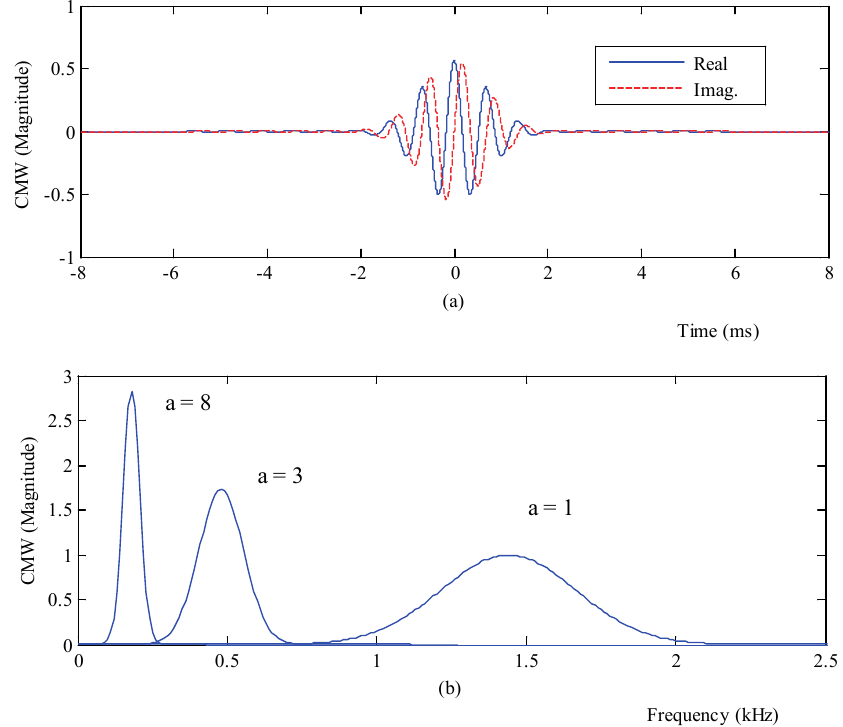
) and ( b ) CMW at different 𝑎𝑎 = 1